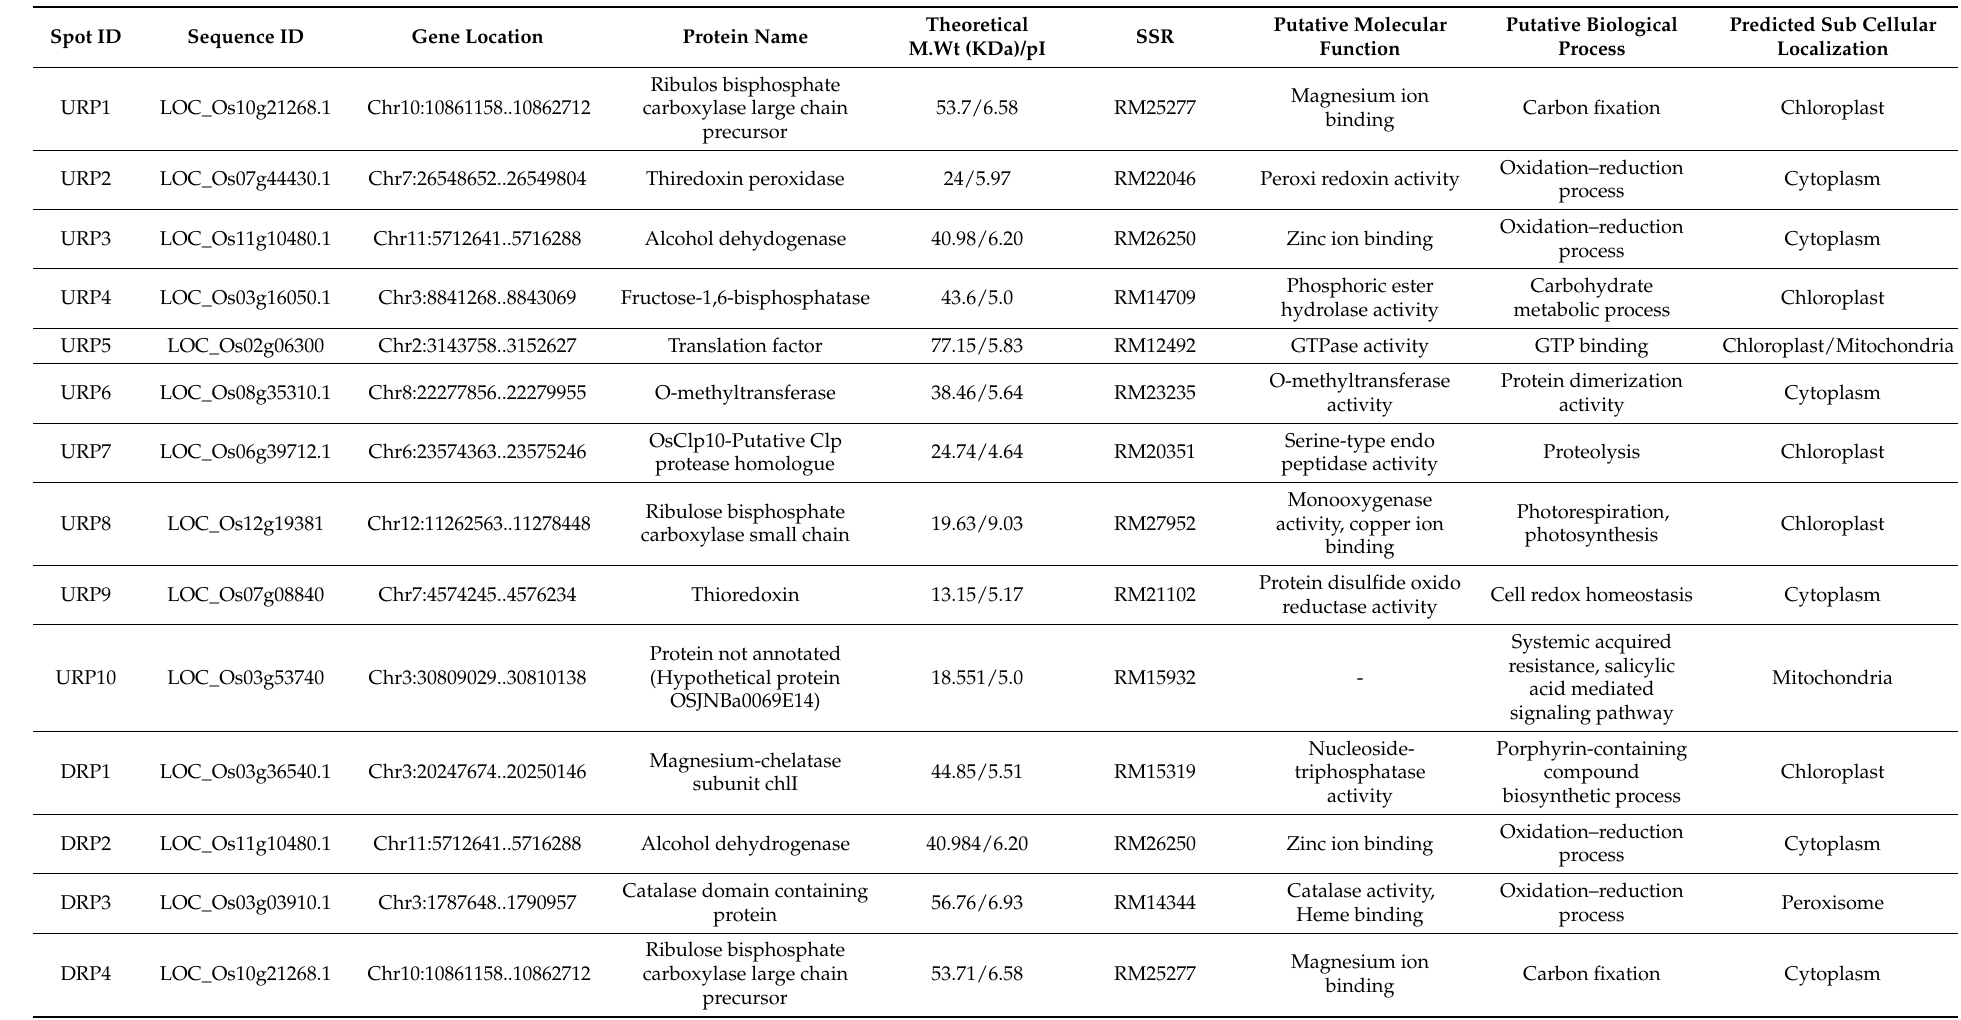
Table 1. List of proteins identified by the MALDI-TOF-MS/MS analysis of cultivated rice cv. Pusa Basmati-1 in response to R. solani